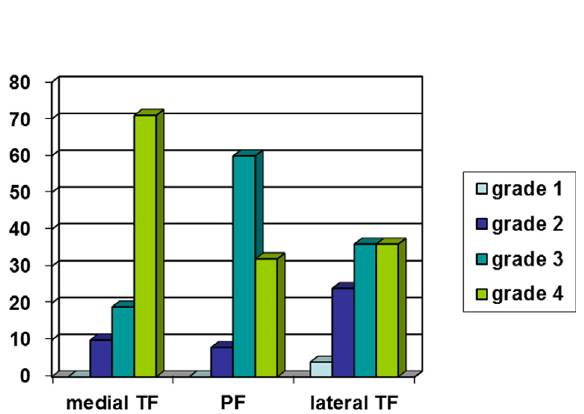
Figure 1. Osteoarthritis distribution in the different compartments according to Outerbridge